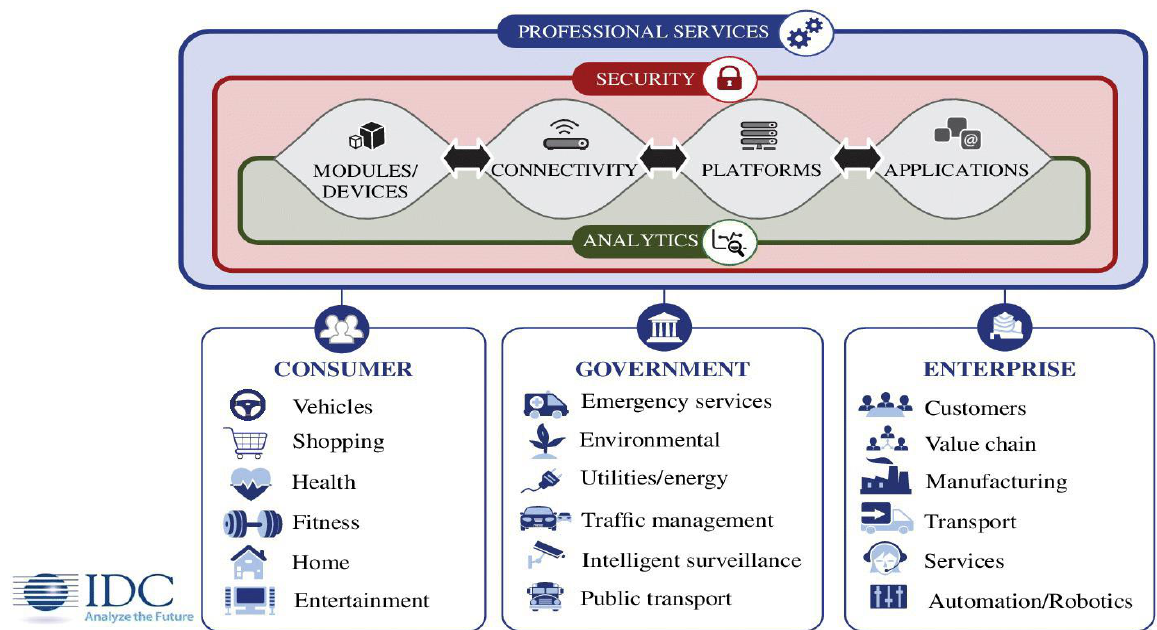
Figure 3. Internet of Things ecosystem. (© International Data Corporation. Use with